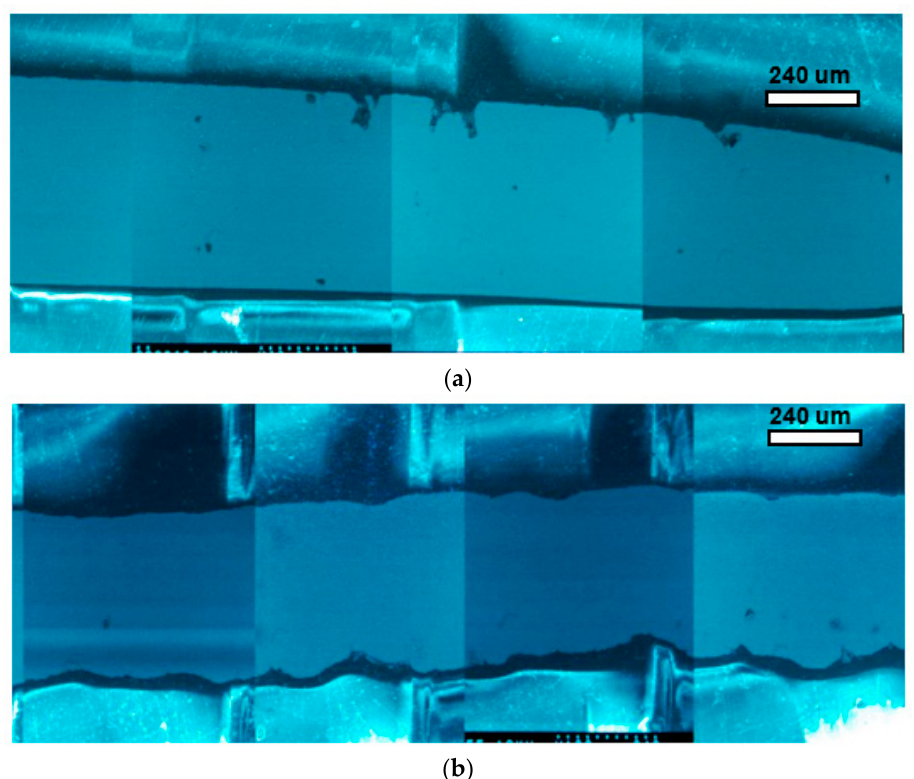
Figure 5. SEM analysis revealed profile and internal defects on both BoneEasy ( a ) and BTK ( b ) samples, probably attributed to the long exposure to a pH 4 buffered solution.